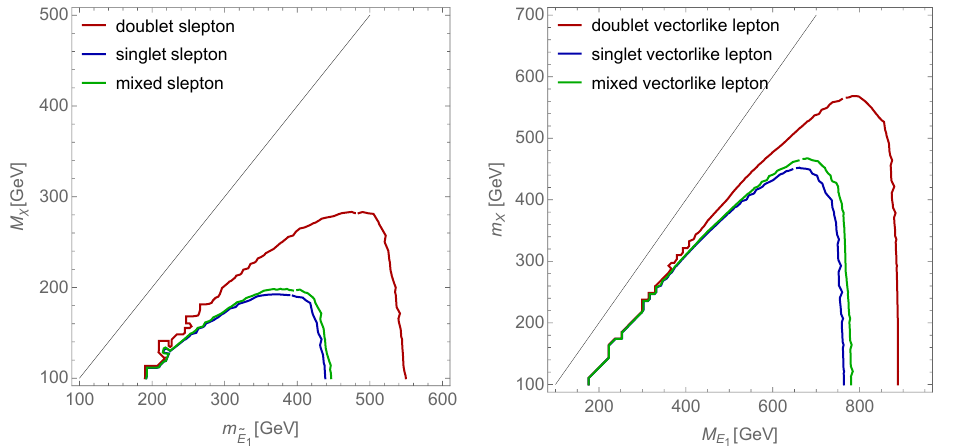
Figure 2 . Experimental limits on the slepton (left) and vectorlike lepton (right) estimated from the ATLAS data